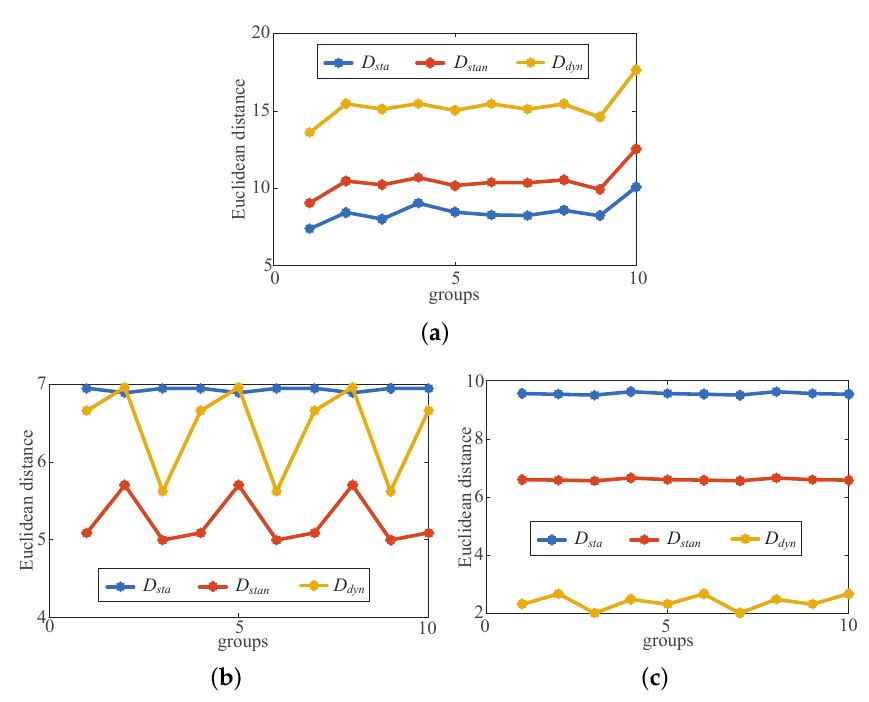
Figure 5. The Euclidean distance of three states under 750 data packets on antenna 1. ( a ) online human-free fingerprint; ( b ) online stationary target fingerprint; ( c ) online moving target